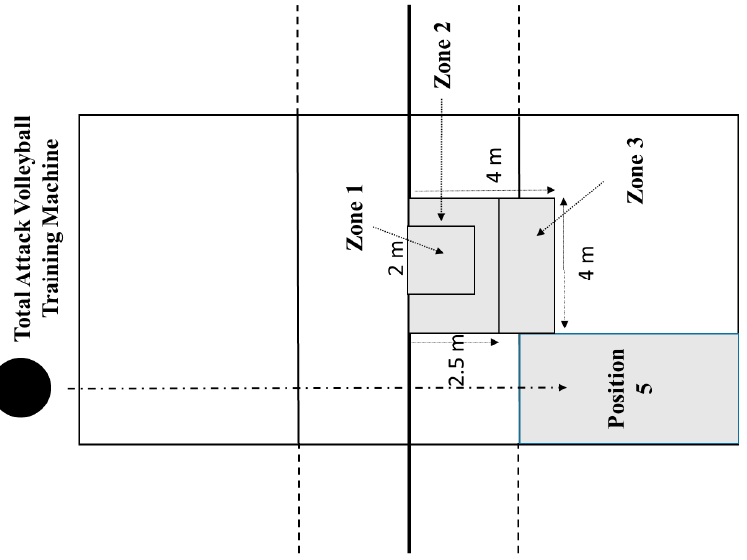
Figure 1. Training and experimental site layout.